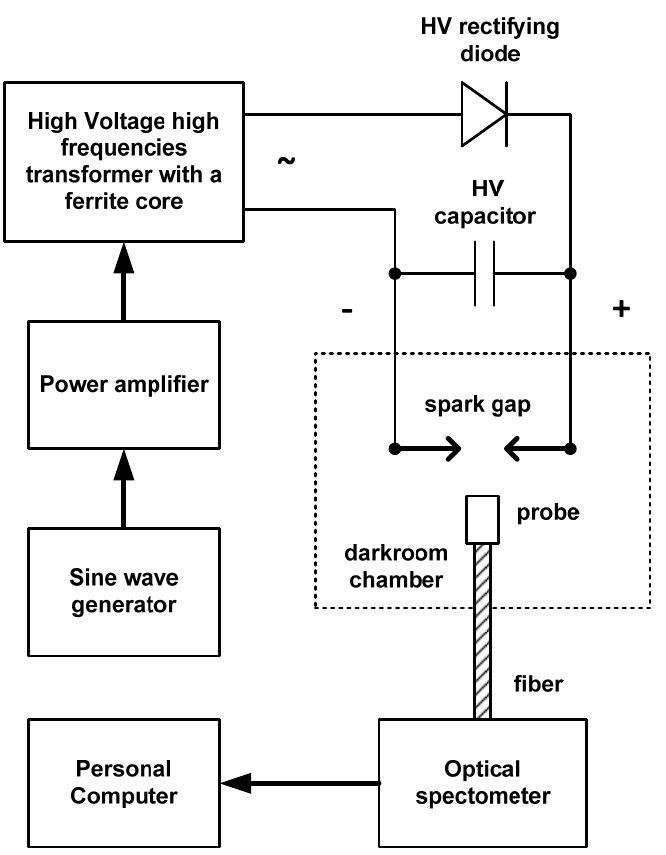
Figure 2. Block diagram of a system for generating an electric arc with a DC-powered spark gap.